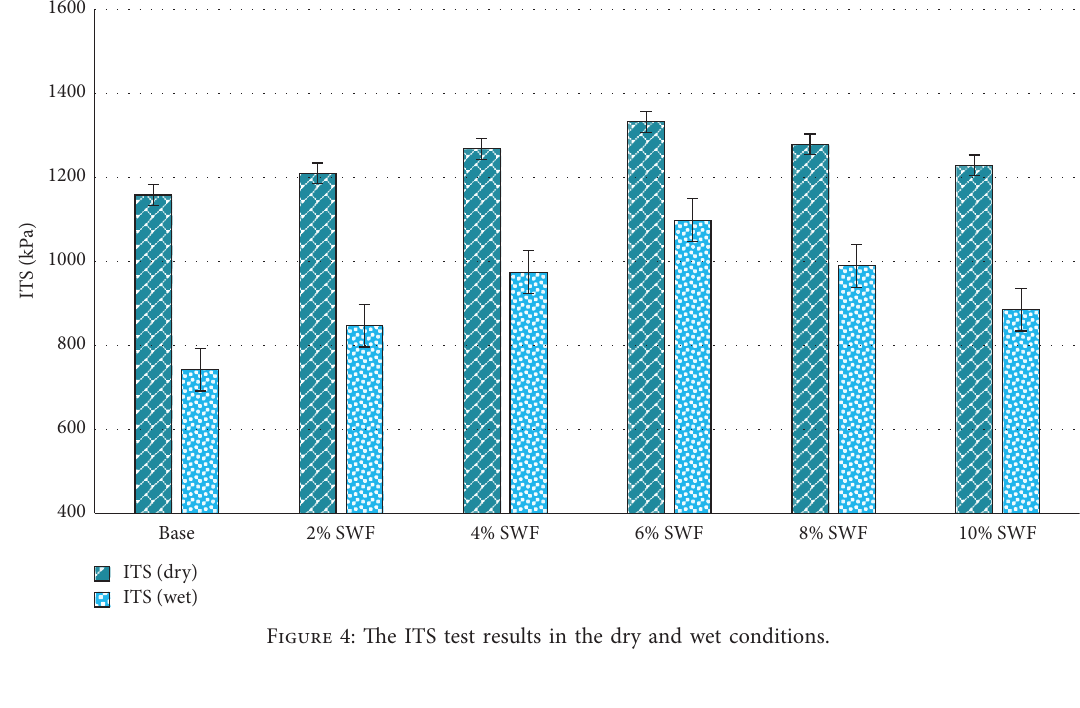
Figure 4: The ITS test results in the dry and wet